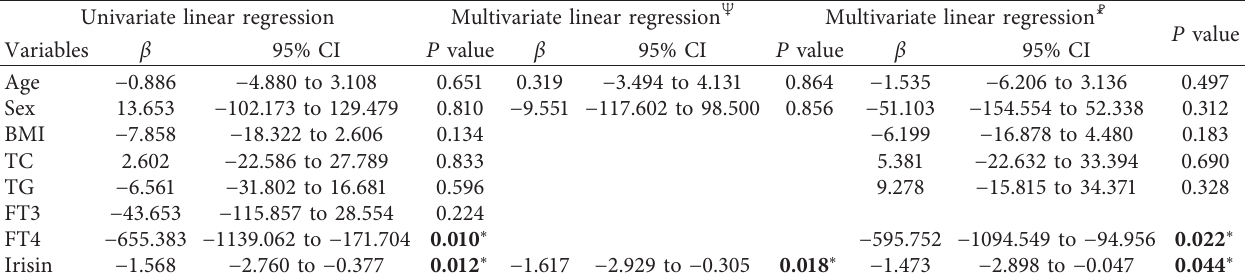
Table 4: Multivariate linear regression for the association of serum irisin levels with native T1 values in severe hypothyroidism patients. Univariate linear regression Multivariate linear regression b Multivariate linear regression